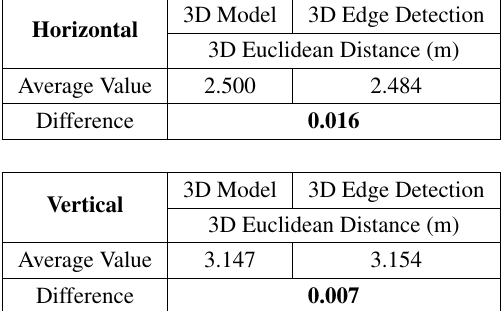
Table 2. Length of each edge as the average 3D euclidean distance between a set of start and end